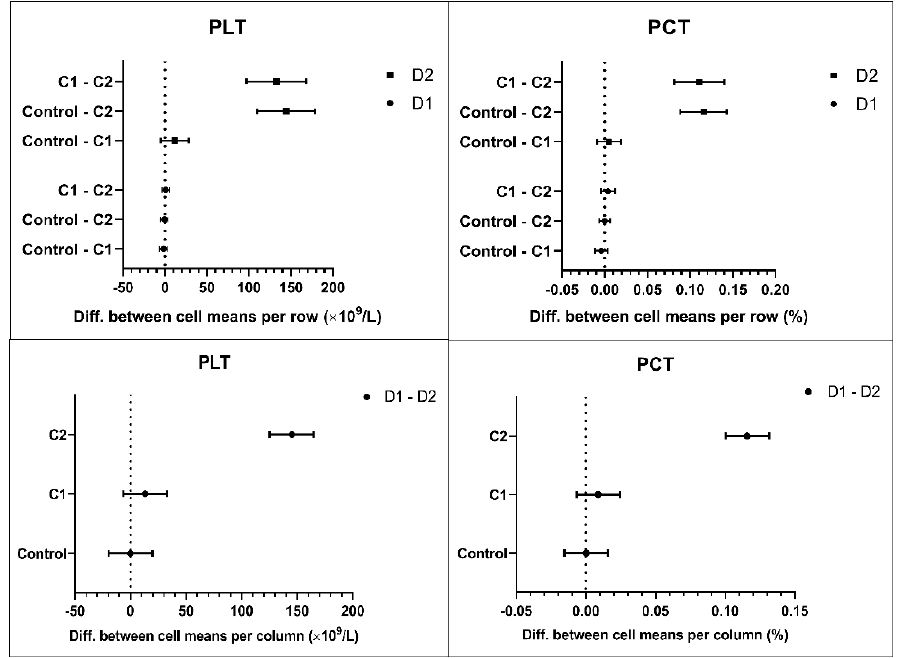
Figure 2. Changes in platelet’s parameters expressed as mean within-subject differences in one factor within the levels of the other factor. The upper plots show simple main effects of concentration, and the lower plots the effect of generation. The symbols denote mean responses with 95% CI. Abbreviations: PLT, absolute number of platelets; PCT,